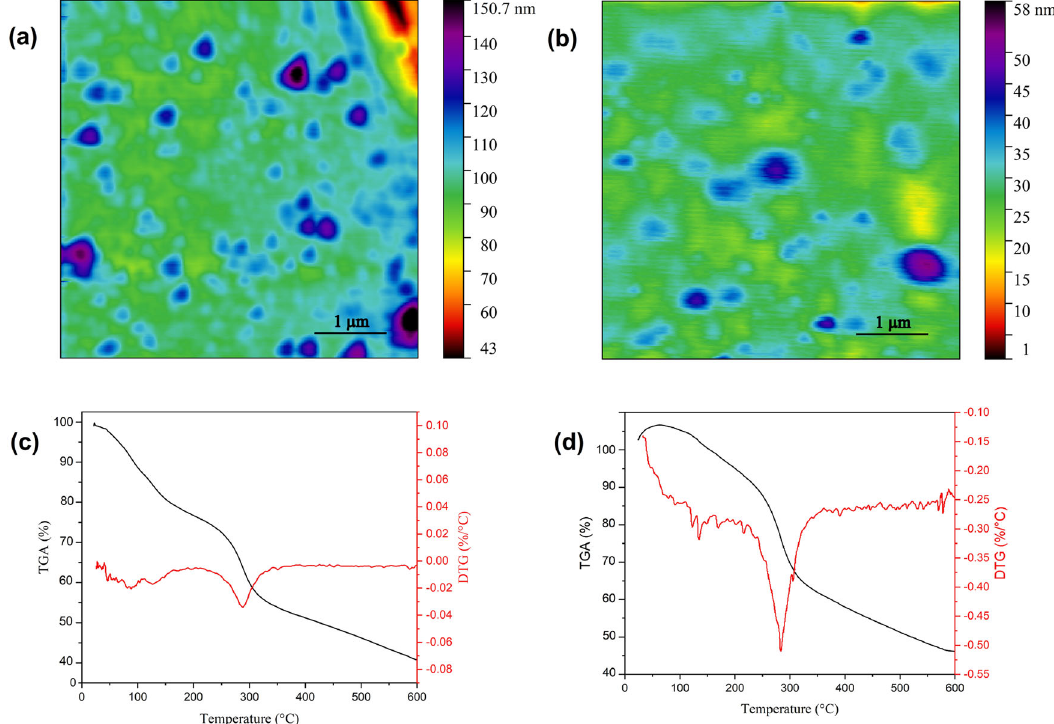
Fig. 7 Atomic force microscopy (AFM) images. a CS-g-gly and ( b ) CMCS-g-gly hydrogels showing nanoparticles morphologies, TGA and DTG of ( c ) CS-g-gly and ( d ) CMCS-g-gly